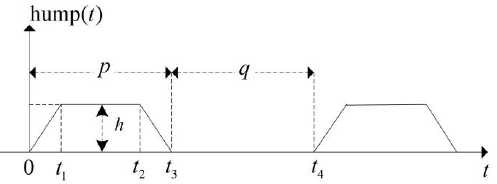
Figure 2. Consecutive SCHs’ geometric